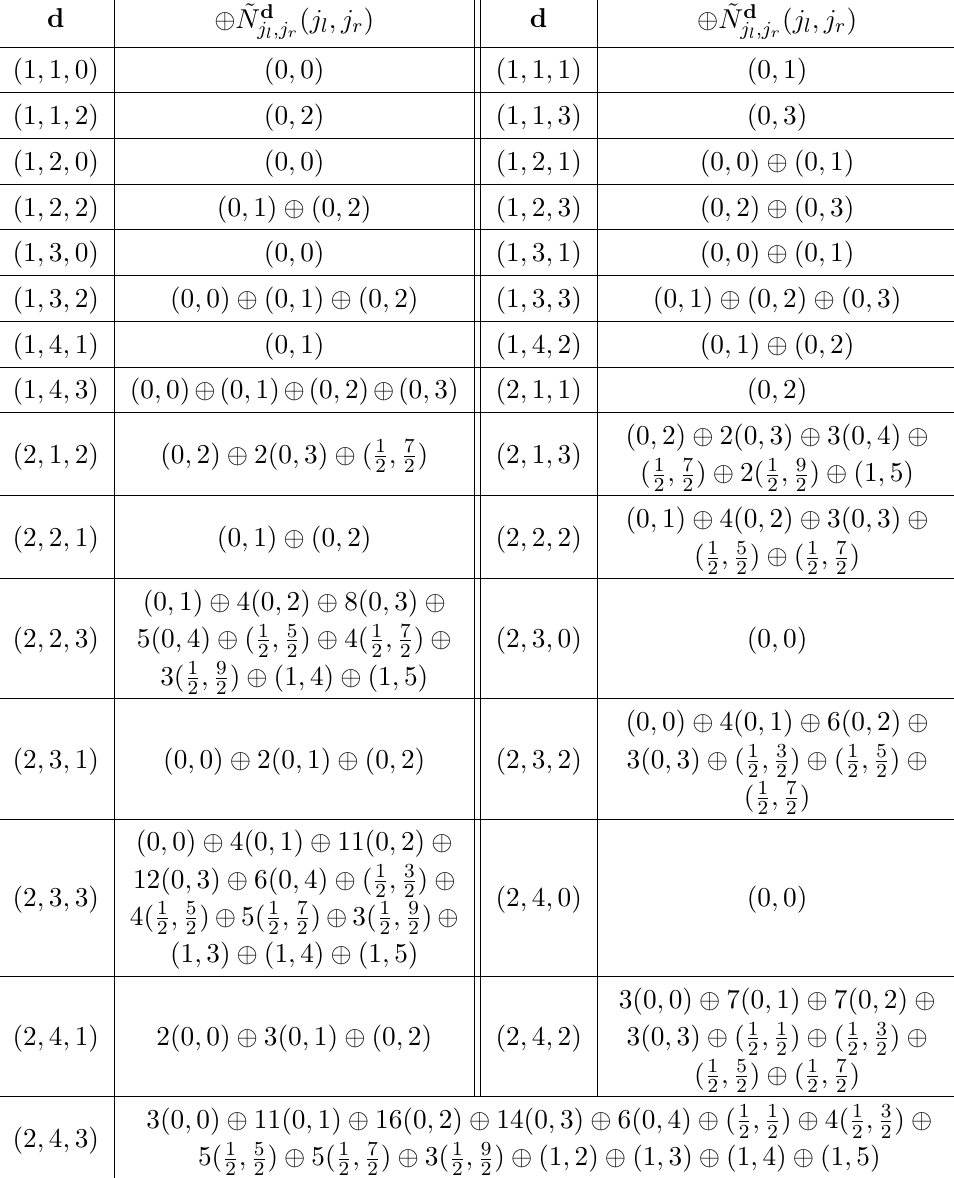
Table 10 . Spectrum of the anti-fundamental Wilson loop in the SU(3) 7 theory for ( d 1 , d 2 , d 3 ) ≤ (2 , 4 , 3) . Here, d = ( d 1 , d 2 , d 3 ) labels the BPS states with fugacity Q − 2 / 3